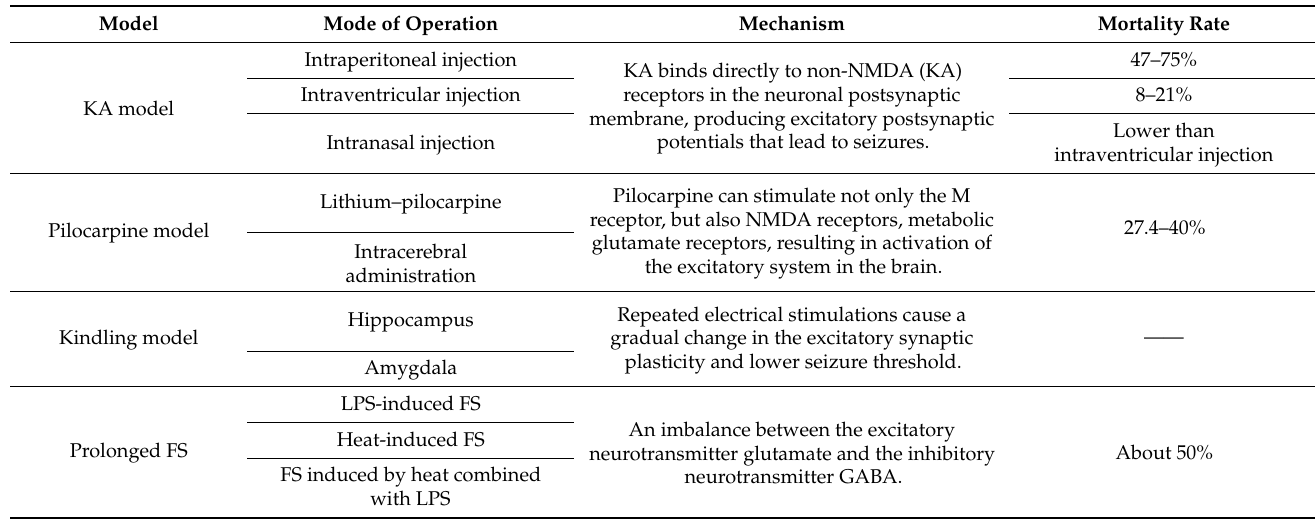
Table 1. Common animal models of